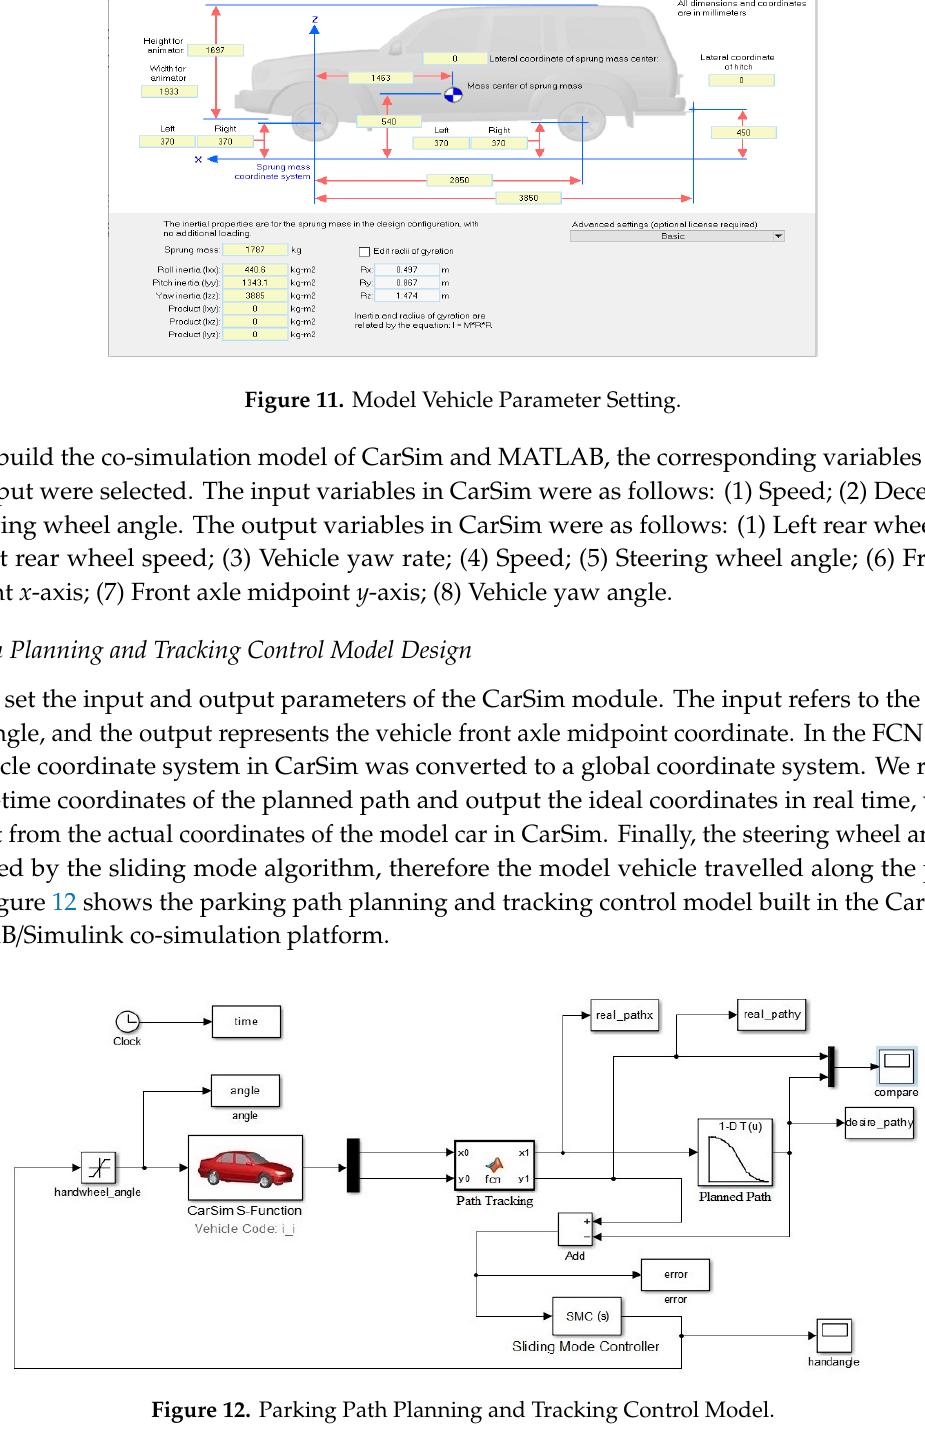
Figure 10. Path Tracking Control Model Based on Sliding Mode Algorithm.